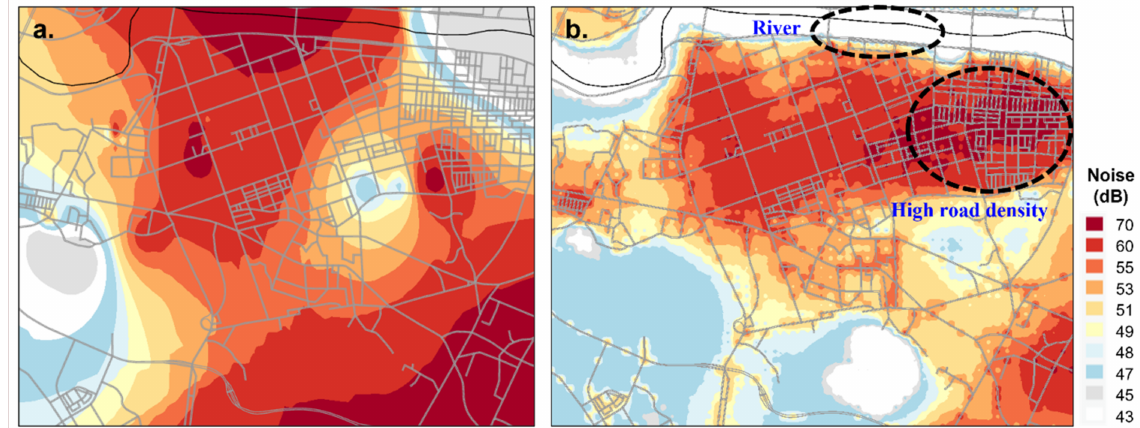
Figure 6. Noise mapping of part of Ulsan region ( a ) noise map based on noise level estimated from Kriging method, ( b ) noise map based on noise level estimated from LUR model.